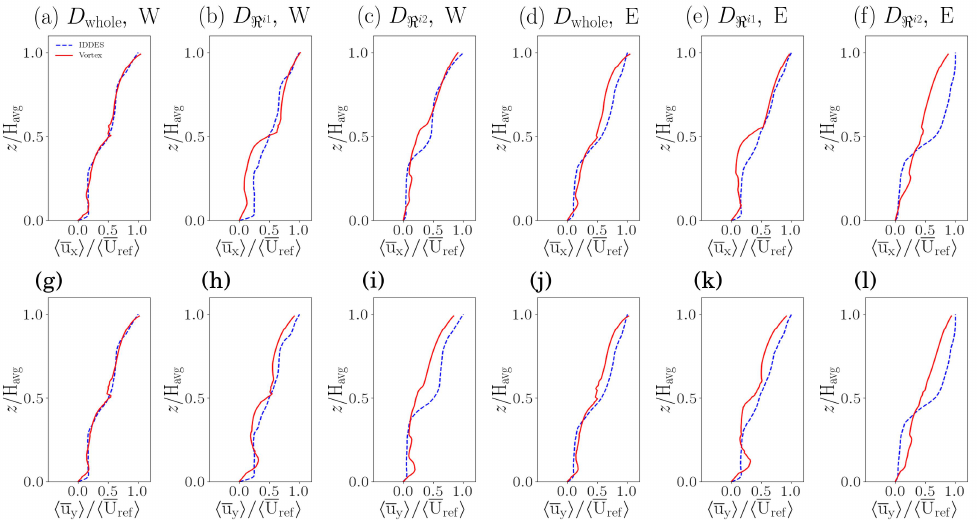
Figure 15. Vertical profiles of normalised mean velocities for the heterogeneous neighbourhood: ( top ) u x ; ( bottom ) u y . The vertical profiles represent horizontal averages over: ( a , d , g , j ) the entire domain (excluding lateral buffer); ( b , e , h , k )